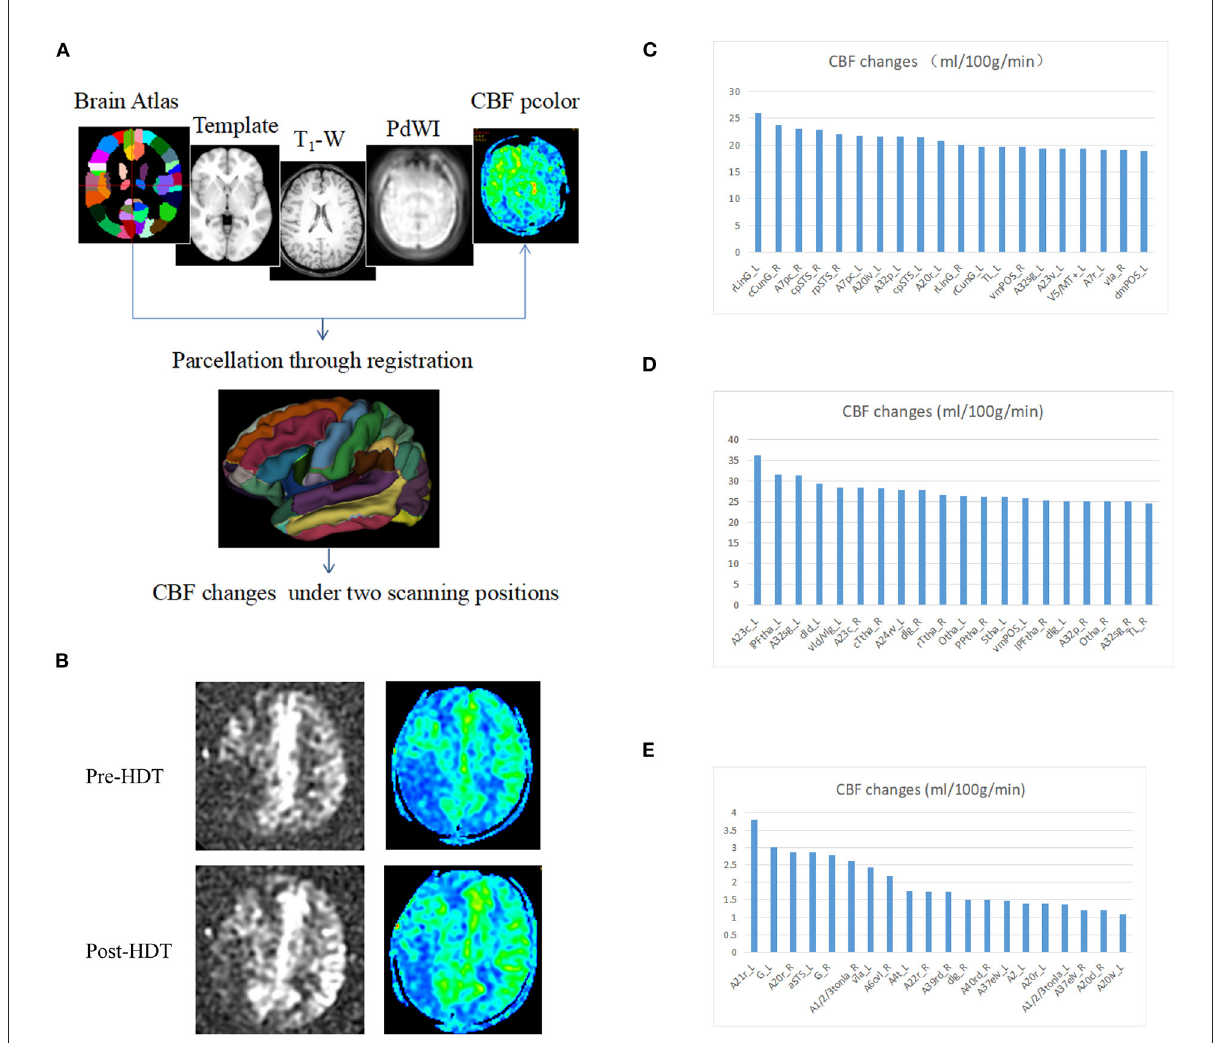
FIGURE2 Changes in cerebral blood flow after head down tilt position. (A) Pipeline for the registration and determination of regions. The Brainnetome Atlas, template, T1-weighted, PdWI and CBF pcolor were used to co-registration and 246 regions of interest were obtained in every subject. In addition, the CBF changes were calculated under two scanning positions (head down tilt position and lying flat position). (B) Representative ASL and CBF pcolor images from Case 1. (C) CBF changes in Case 1. (D) CBF changes in Case 3. (E) CBF changes in Case 4. ASL, arterial spin labeling; CBF, cerebral blood flow; HDT, head down